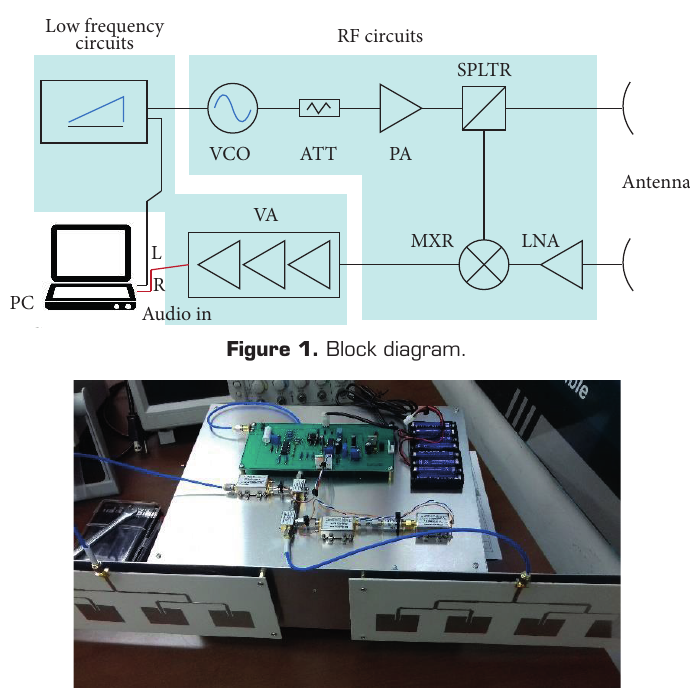
Figure 2. Snapshot of the radar implemented at